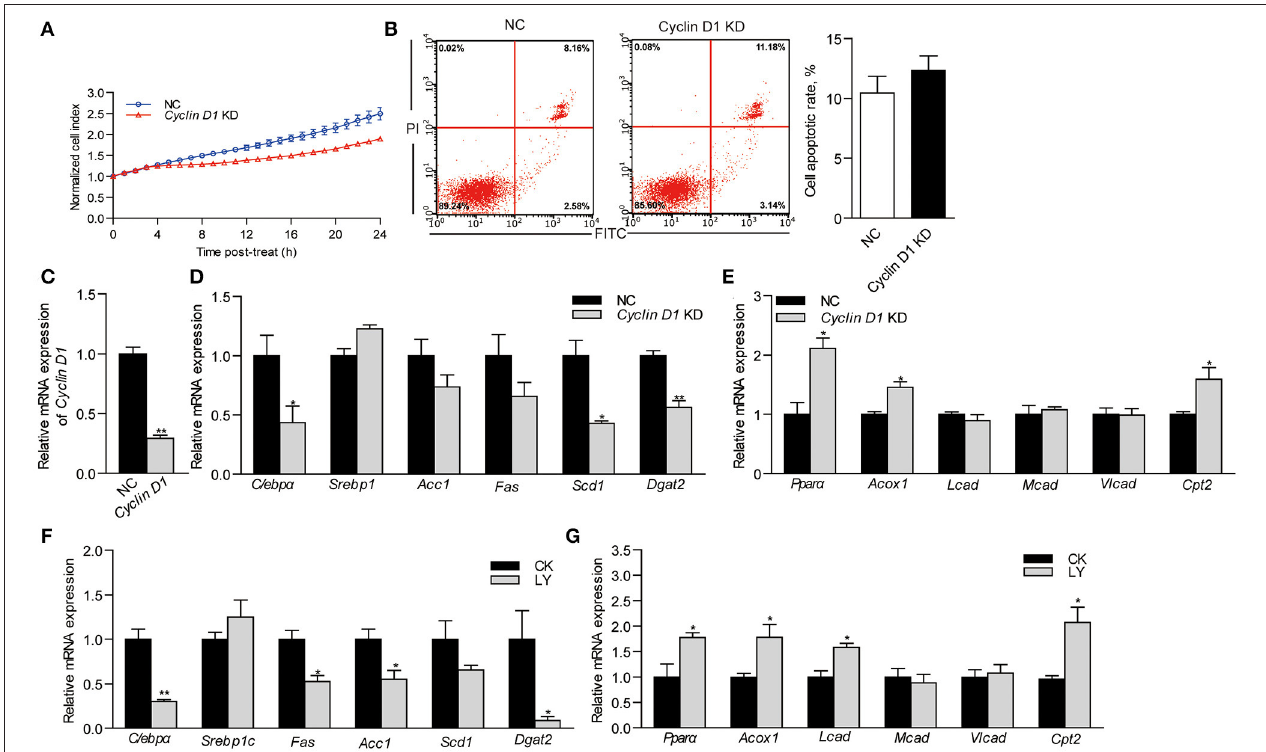
FIGURE 5 | Effects of Cyclin D1 knockdown and Cyclin D1-Cdk4 blocking on lipid metabolism. (A) Growth of NC and Cyclin D1-knockdown ZFL cells. (B) Apoptosis of NC and Cyclin D1-knockdown ZFL cells. (C) Efficiency of si RNA targeting cyclin D1 in ZFL cells. (D) Relative mRNA expression of genes related lipid synthesis in ZFL cells with Cyclin D1 knockdown. (E) Relative mRNA expression of genes related β -oxidation in ZFL cells with Cyclin D1 knockdown. Relative mRNA expression of genes related (F) lipid synthesis and (G) lipid β -oxidation in ZFL cells treated with LY2835219. Values are means ± SEMs ( n = 3 biological replicates). * P < 0.05; ** P <